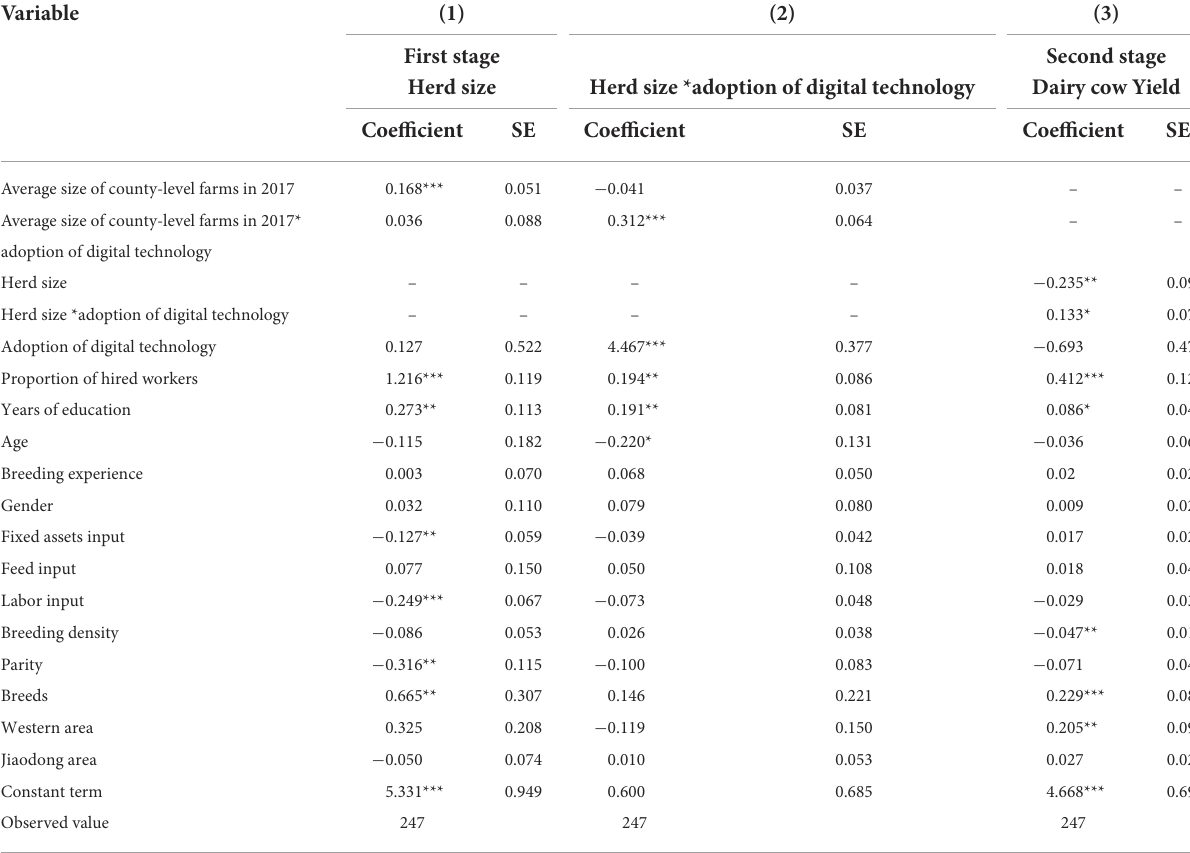
TABLE 4 Empirical results on the impact of digital technology adoption on the relationship between herd size and dairy cow yield by 2SLS.